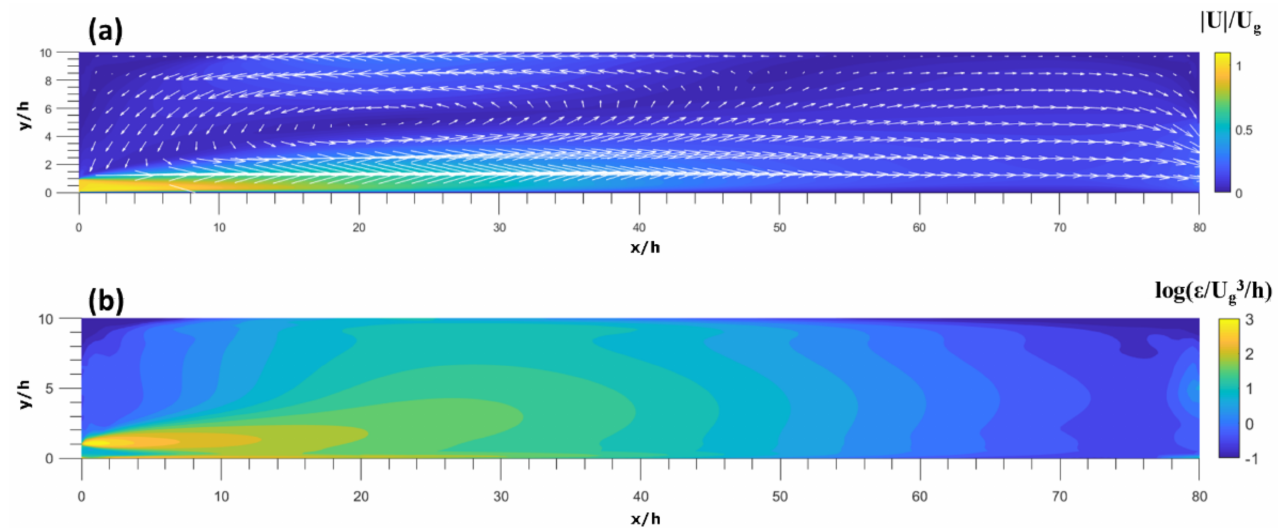
Figure 4. ( a ) Average velocity, | U |, and ( b ) dissipation rate of TKE, ε , in the flow geometry, scaled with gap velocity, U g , and gap height, h . ( U g = 3.0 m/s). Note the logarithmic scale in